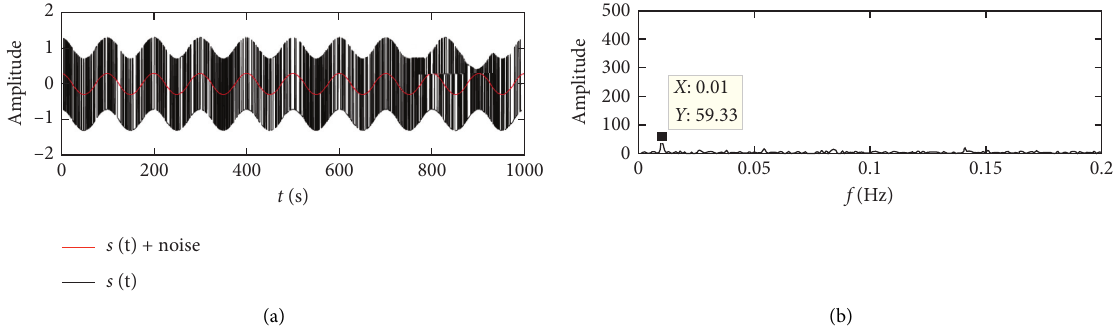
Figure 4: (a) The time-domain diagram of noisy signal and (b) the power spectrum diagram of the noisy signal.